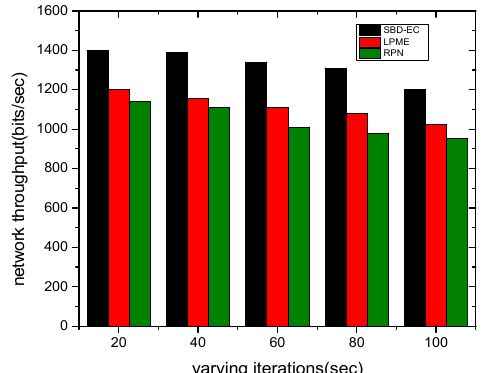
Figure 6. Network throughput and iterations.